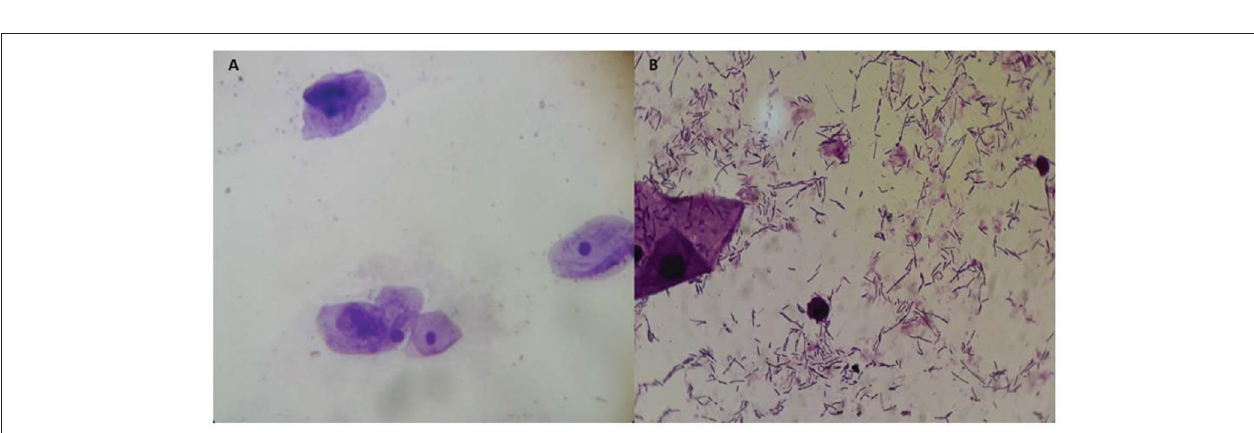
FIGURE 2 | Before (A) and after treatment (B) . Adapted from Sarmento et al.